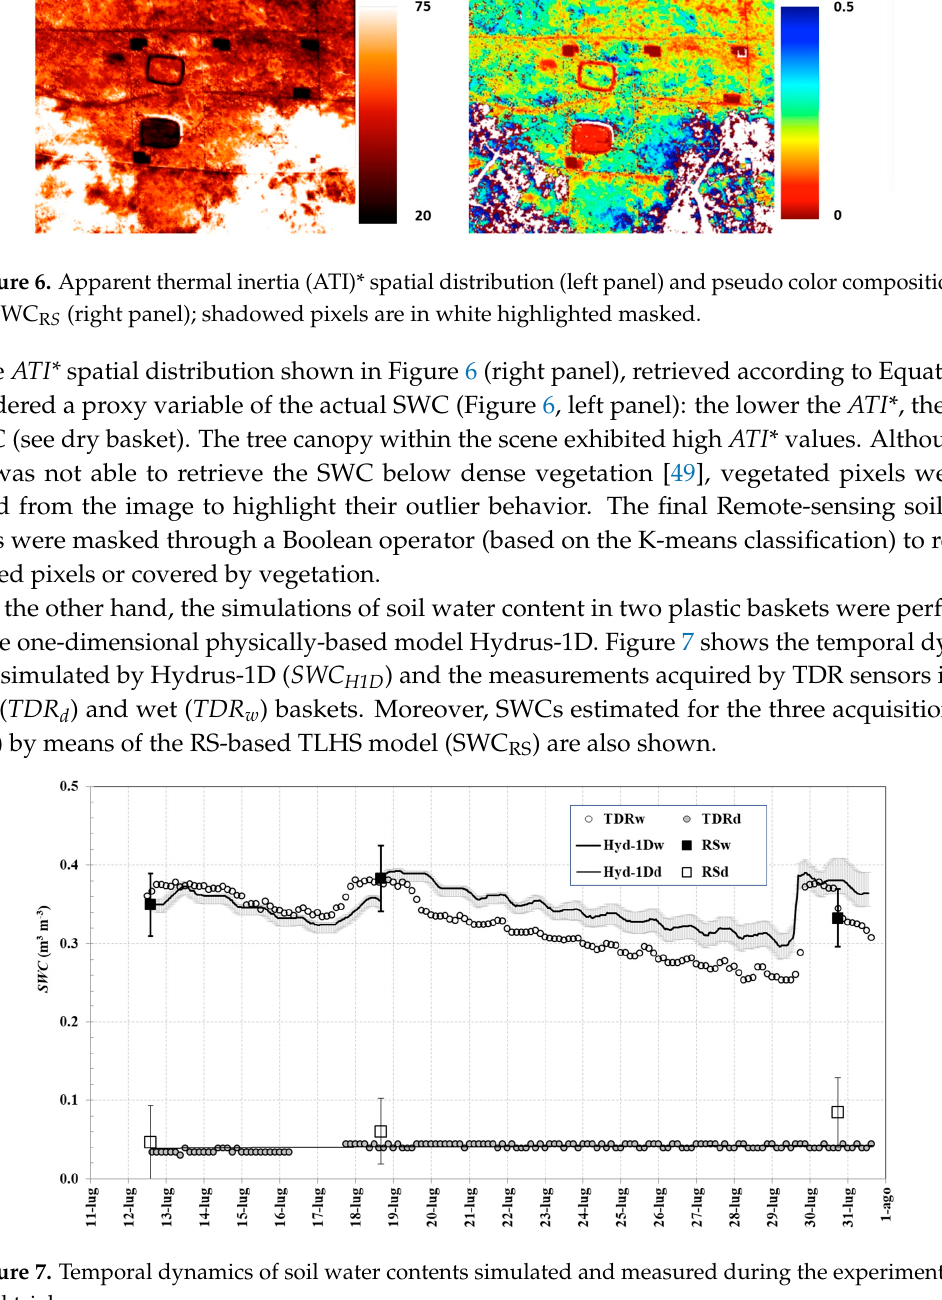
Figure 7. Temporal dynamics of soil water contents simulated and measured during the experimental field trial. field